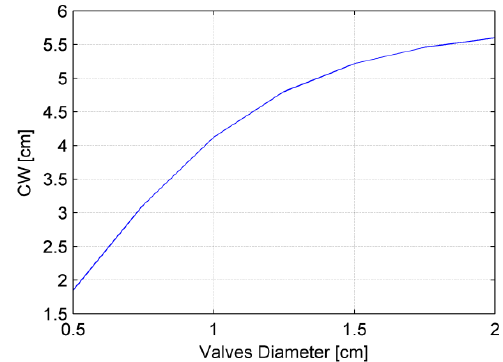
Figure 22. CW as function of the valves